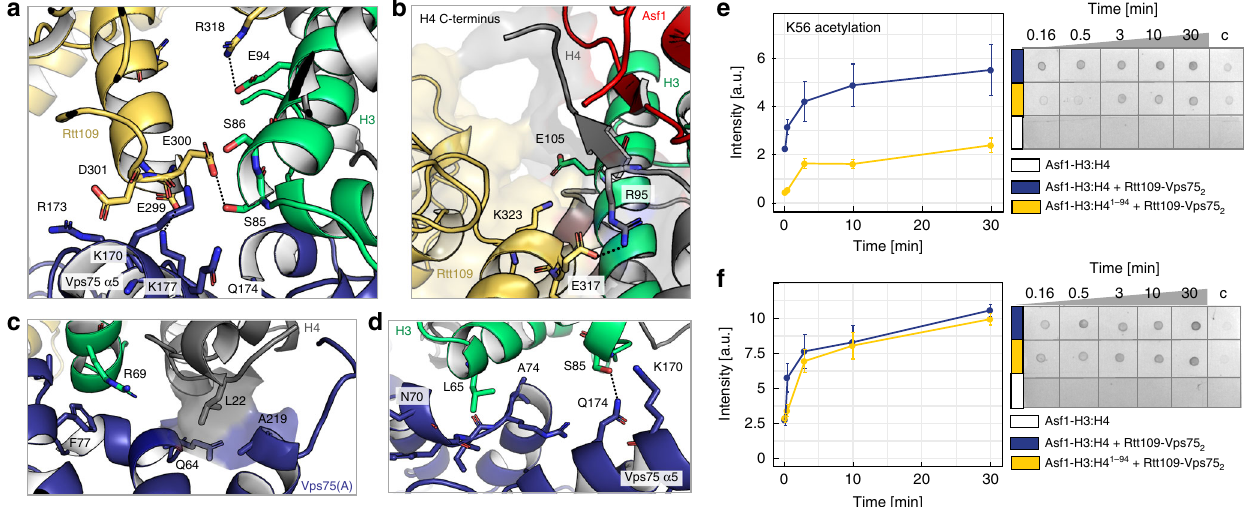
Fig. 2 K9-acetylation does not depend on the H4 C-terminal region. a The interface of H3, Rtt109 and Vps75(A) displays a network of hydrogen bonds (dashed lines) and electrostatic contacts. b Interface between the H4 C-terminal region and Rtt109. c , d Interface of H3:H4 and Vps75(A): hydrophobic contacts involve H4-L22, H3-R69 and L65, Vps75-F77, Q64, A219 and the backbone of stretch 70 – 74; electrostatic contacts involve Vps75-K170 and Q174 and H3-S85. e , f Time-courses (left) of K56- and K9-acetylation quanti fi ed by dot-blot assays (right). The H4 95 – 102 stretch is important for K56ac ( e ) but not for K9ac ( f ). Experimental conditions: 0.2 μ M Rtt109 – Vps75 2 , 0.2 μ M Asf1 − H3:H4, 2 μ M Ac-CoA, 10 mM HEPES pH 8.0, 100 mM NaCl. Because the control reaction with 0.2 μ M Asf1 − H3:H4 (white) did not give signal above the background, an additional negative control with 6 μ M Asf1 − H3:H4 (column “ c ” ) was used for normalization and comparison of the experimental repeats. The data were averaged over four experiments; the error bars are the standard errors of the means. Source data are provided as a Source Data fi le